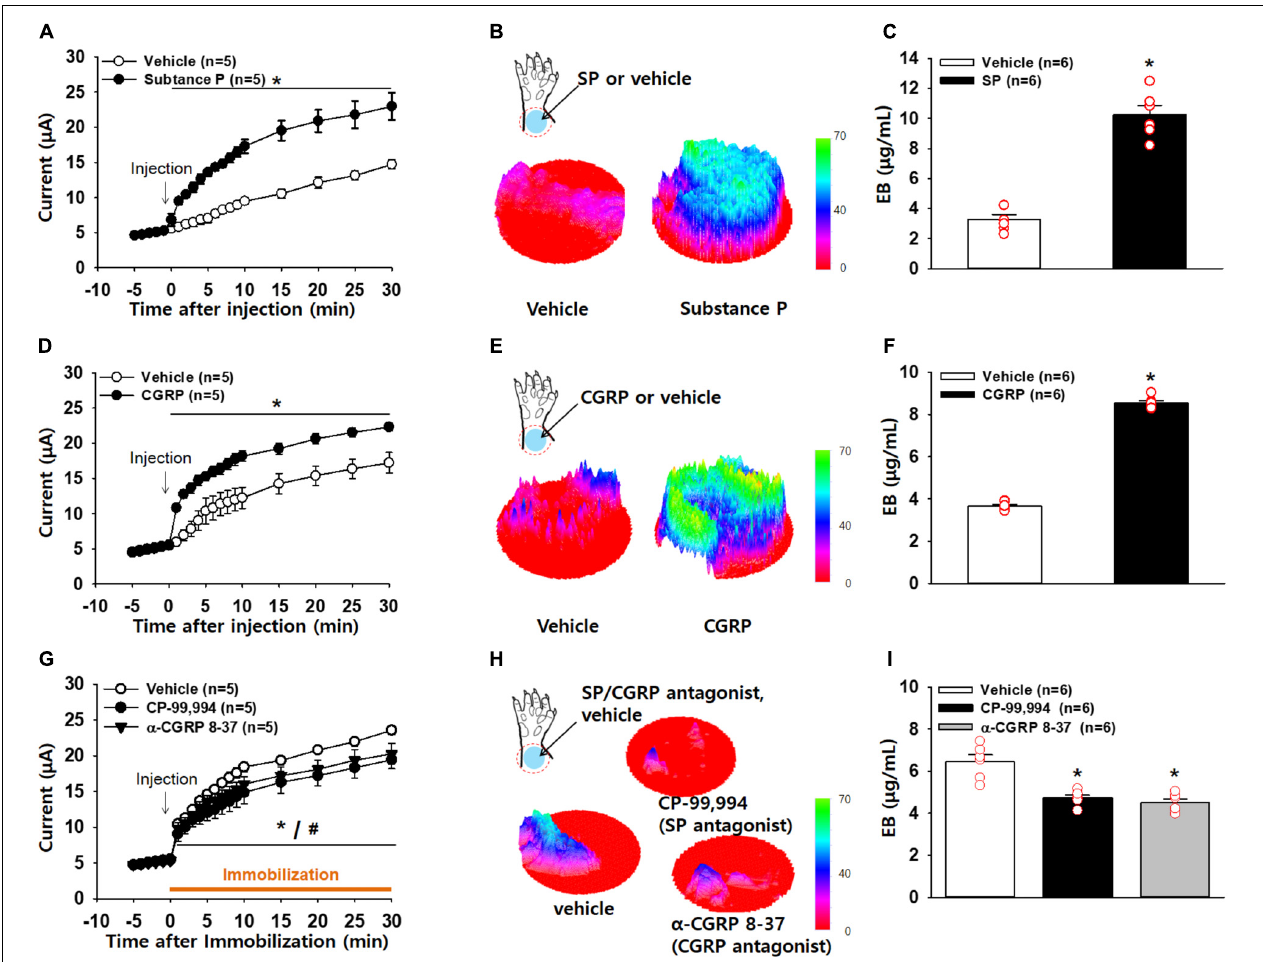
FIGURE 5 | Increased conductance at acupoints by SP or CGRP. (A–C) Effect of intradermal substance P (SP) on electrical conductance in naïve rats. Injection of SP into the skin of the wrist acupoints significantly increased conductance compared to injection of vehicle (A) . p < 0.05 vs. vehicle. The three-dimensional (3D) images of EBD extravasation in the wrist skin in vehicle- or SP–treated rats (B) and the concentration of EBD in the wrist acupoints of vehicle- or SP-treated rats (C) . ∗ p < 0.001 vs. vehicle. (D–F) Effect of intradermal calcitonin gene-related peptide (CGRP) on electrical conductance in naïve rats. Injection of CGRP into the skin of the wrist acupoints significantly increased conductance compared to injection of vehicle (D) . The 3D images of EBD extravasation in the wrist skin in vehicle- or CGRP-treated rats (E) and the concentration of EBD in the wrist acupoints of vehicle- or CGRP-treated rats (F) . ∗ p < 0.001 vs. vehicle. (G–I) Effects of intradermal SP or CGRP antagonists on the development of high conductance in hypertensive rats. Injection of SP or CGRP antagonists into the skin of the wrist acupoints prevented the development of high conductance in IMH rats compared to injection of vehicle (G) . The 3D images of EBD in the wrist skin in vehicle- or SP or CGRP antagonist-treated rats (H) and the concentration of EBD in the wrist acupoints of vehicle- or SP or CGRP antagonist-treated rats (I) . ∗ p = 0.003 vs.